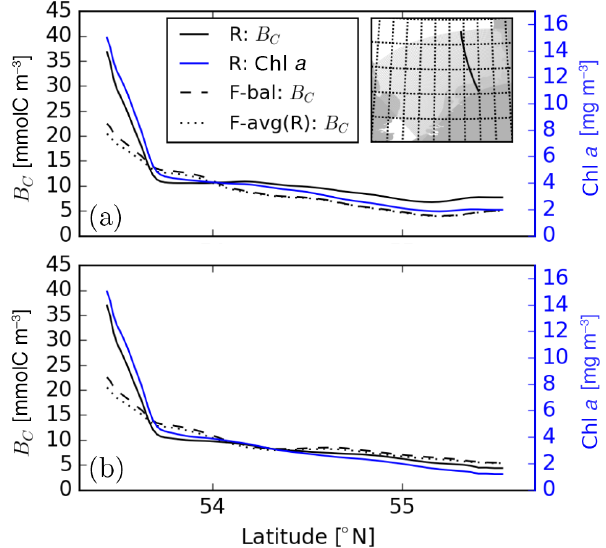
Figure 14. Annual average phytoplankton carbon (and for R , chlorophyll) concentrations in 2010 (a) at the surface layer; (b) av- eraged over the water column; and obtained with the following models: R is the reference (acclimative) model, F-bal is the fixed- physiology model with balanced investments and F-avg( R ) is fixed- physiology model with allocation parameters as average trait values produced by R